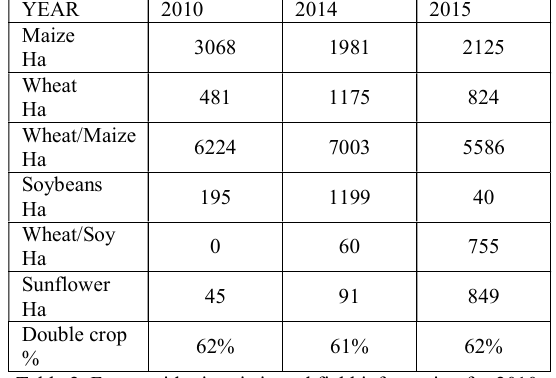
Figure 35. Maize in summer only under pivot irrigation increase or decrease per district between 2014 and 2015